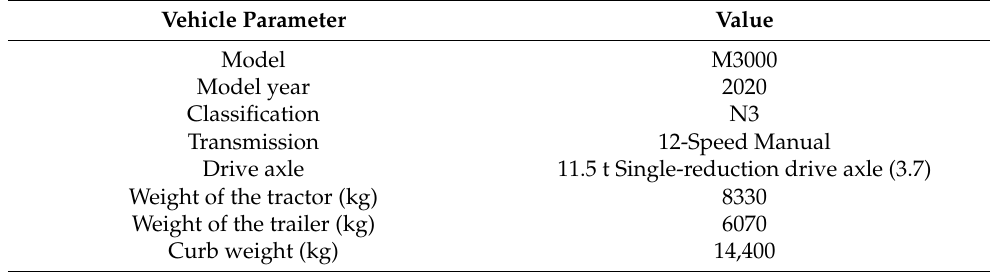
Table 3. Specifications of the vehicle.